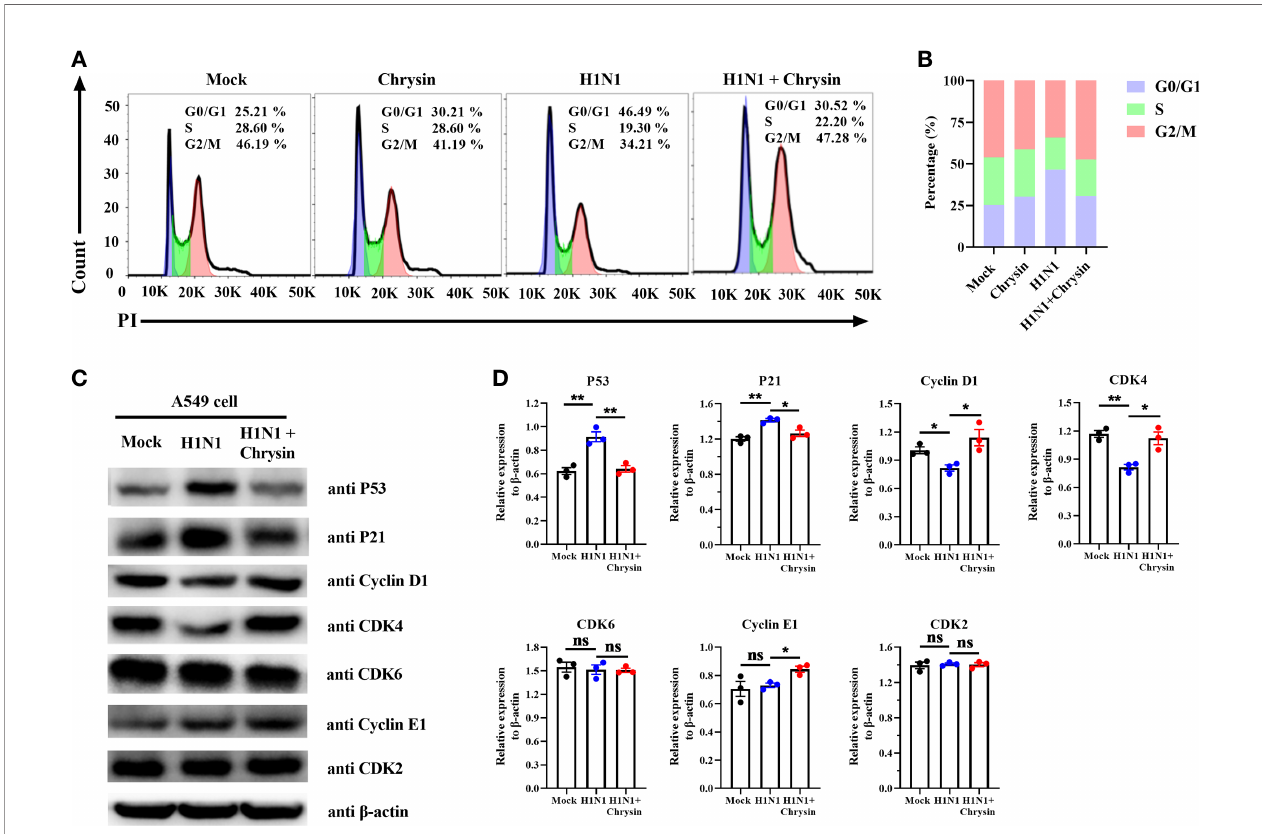
FIGURE 5 | Chrysin retards H1N1 in fl uenza virus-induced G0/G1 cell cycle arrest in epithelial cells. (A) A549 cells were infected with A/PR/8/34 (H1N1) virus (MOI = 0.5) in the presence or absence of chrysin for 2 hours, then the supernatant was removed and supplemented by fresh medium containing 8 m M chrysin for 10 hours stimulation. Cycle distribution was assessed using fl ow cytometry. (B) statistical charts of the cell population in G0/G1, S, and G2/M phases. (C) A549 cells were infected with A/PR/8/34 (H1N1) virus (MOI = 0.5) for 2 hours in the presence or absence of 8 m M chrysin, then the supernatant was discarded, and